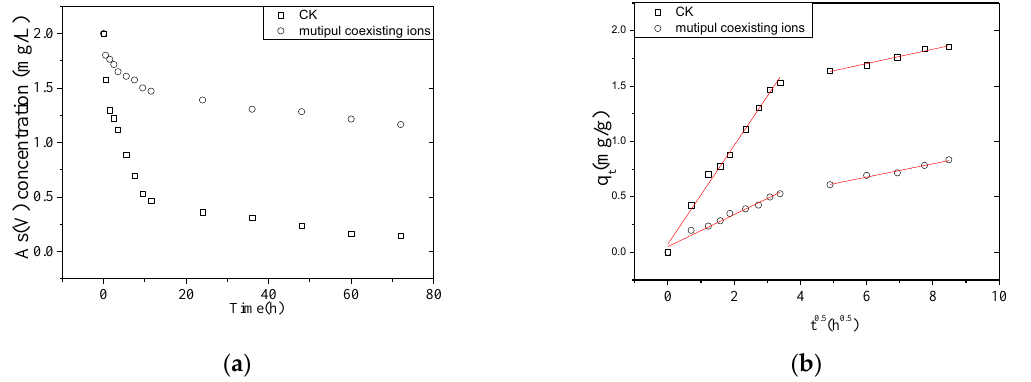
Table 7. The adsorption kinetic model rate constants for the As (V) on NZVI/AC in the presence of multiple coexisting ions.